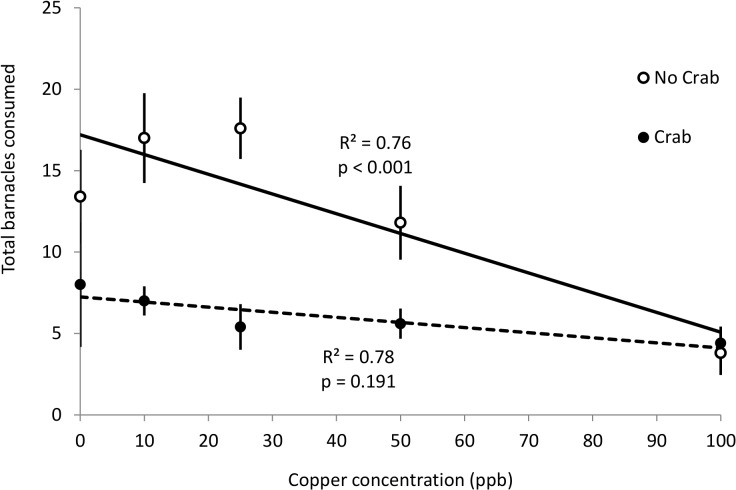
Effects of crab predator and copper concentrations on whelk consumption rates.Mean (±SEM) total number of barnacles consumed by whelks under No Crab (empty circles; n = 5) and Crab (filled circles; n = 5) treatments when exposed to five different copper concentration treatments (n = 5). R2 and p-values are from a linear regression of the five copper concentrations with either No Crab (solid line) or Crab (dashed line) treatments. Dashed line for Crab treatments shown for clarity although not a statistically significant regression.